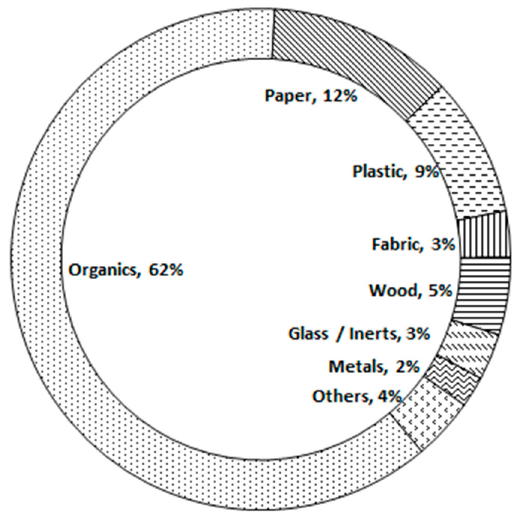
Figure 6. Gravimetric composition of MSW in Havana.